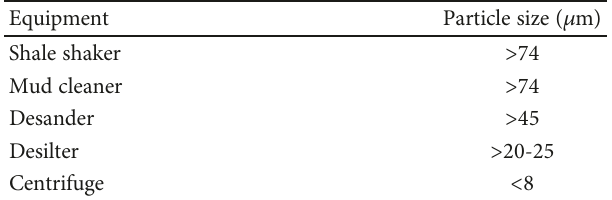
Table 1: Solid removal by type of equipment.